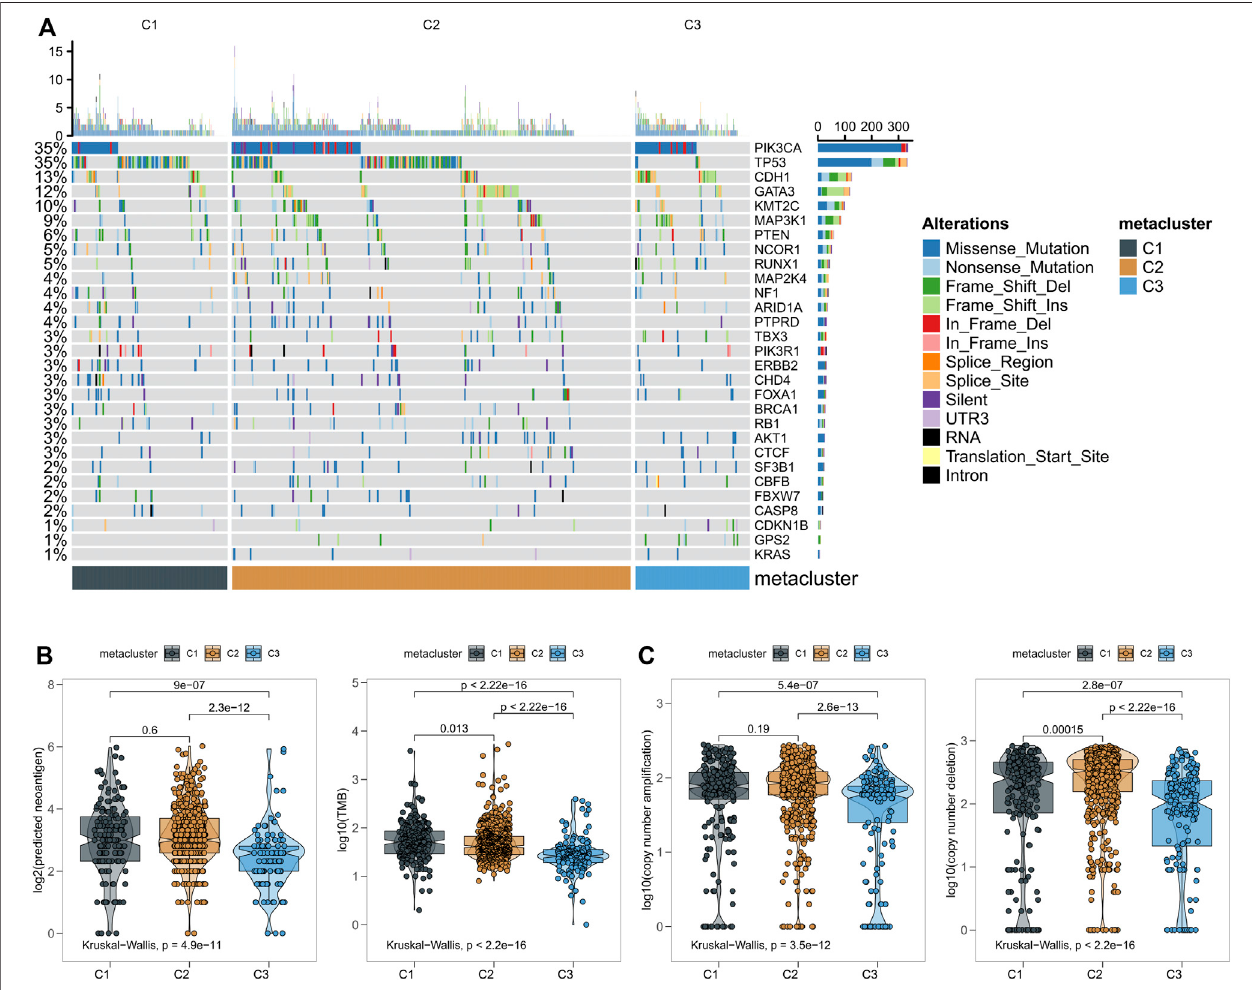
FIGURE 4 | (A) The relationship between three subtypes of breast cancer and the classical pathway of mutation and related genes; (B) Number of mutations and predicted neoantigens in the three breast cancer subgroups; (C) Copy number aberrations in three breast cancer subtypes.